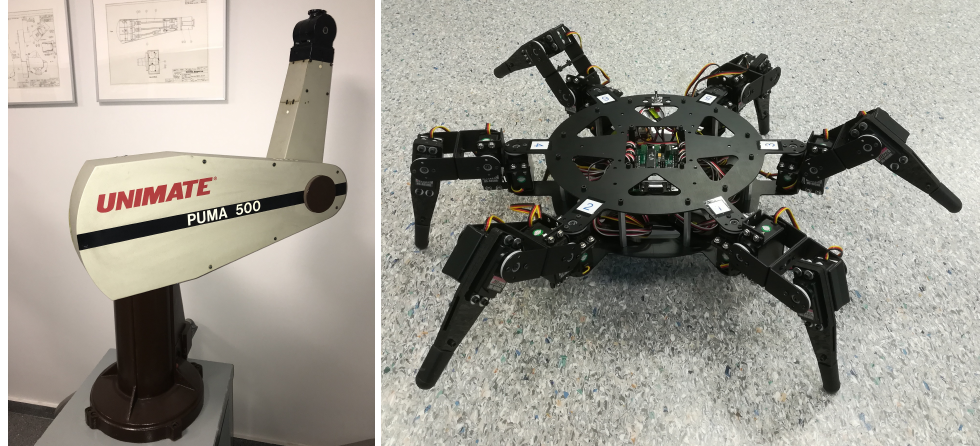
Figure 2. Robotic systems used in this project: Unimate’s PUMA 560 robotic arm ( left ) and BH3-R hexapod walking robot by Lynxmotion Inc. ( right